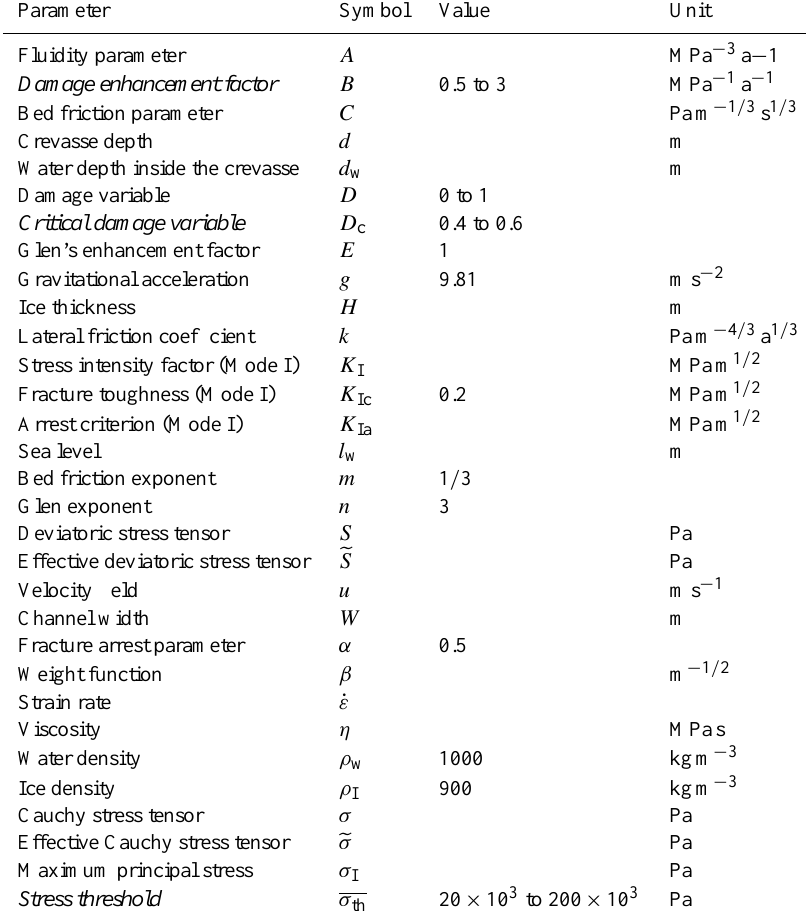
Table A1. Physical and numerical parameters. Tunable parameters are in